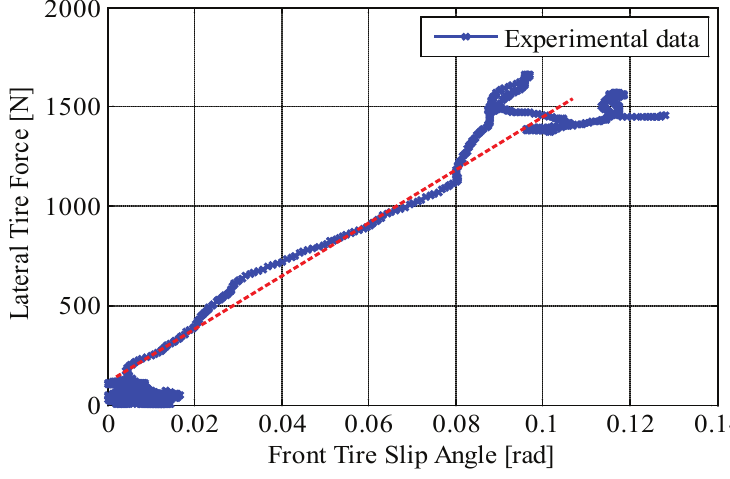
Figure 13. Front tire cornering stiffness on a high- µ road ( µ (cid:39) 0 . 9 ): relationship curve between measured lateral tire force and measured tire slip angle.